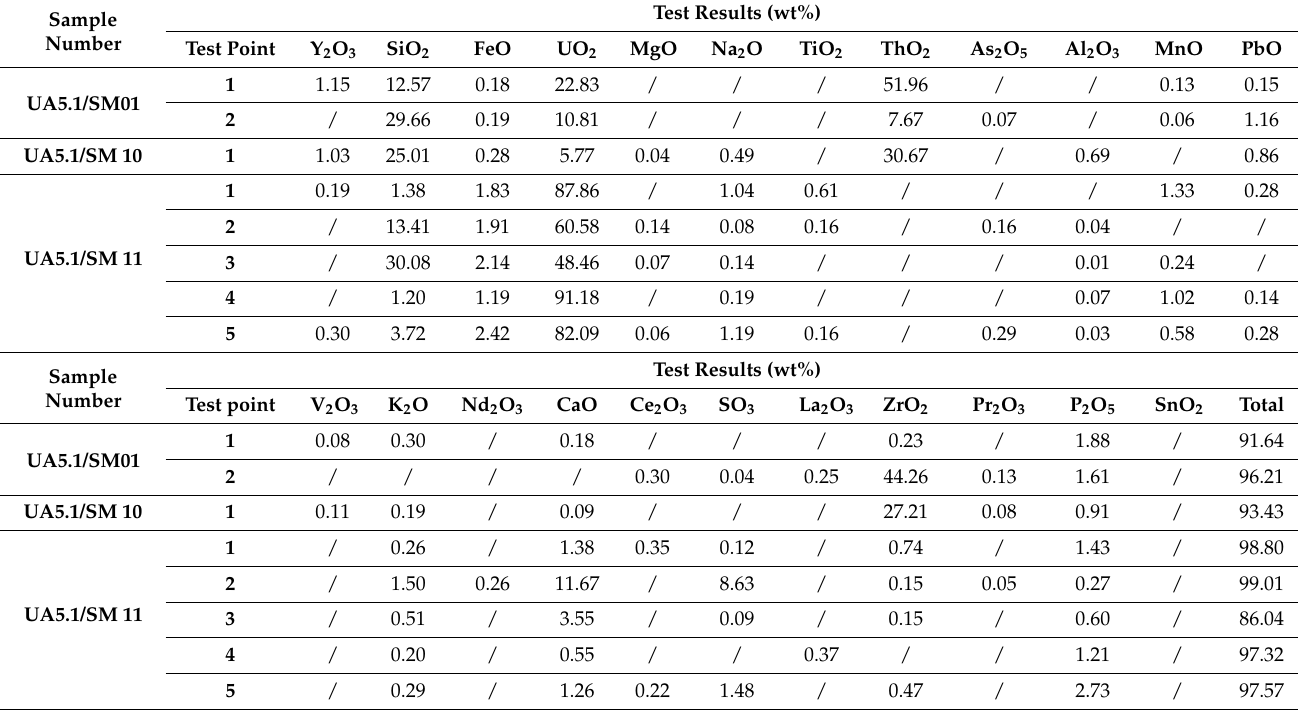
Table 4. Contents of elements (in wt.%) of EPMA data in ferruginous sandstone.